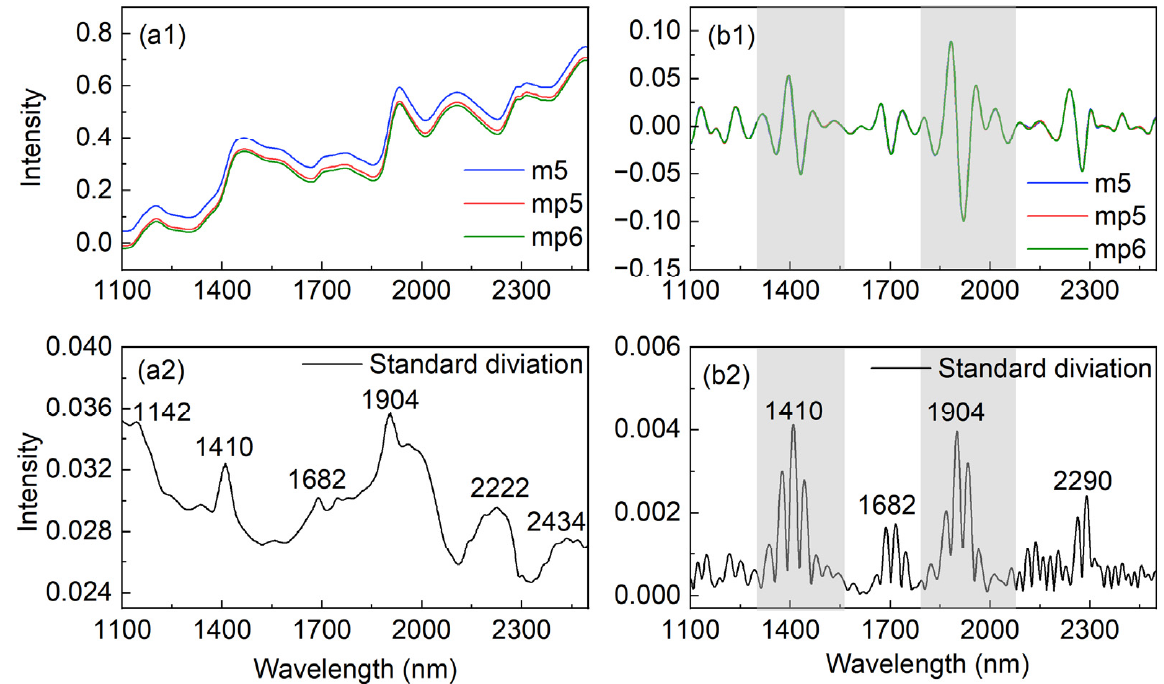
Figure 1. Average NIR spectra of corn samples from instrument m5, mp5, and mp6, respectively ( a1 ), standard deviation of the averaged spectra ( a2 ), average spectra from each instrument after CWT transformation ( b1 ), and standard deviation of the CWT processed spectra ( b2 ). The selected ranges were indicated with shadows.